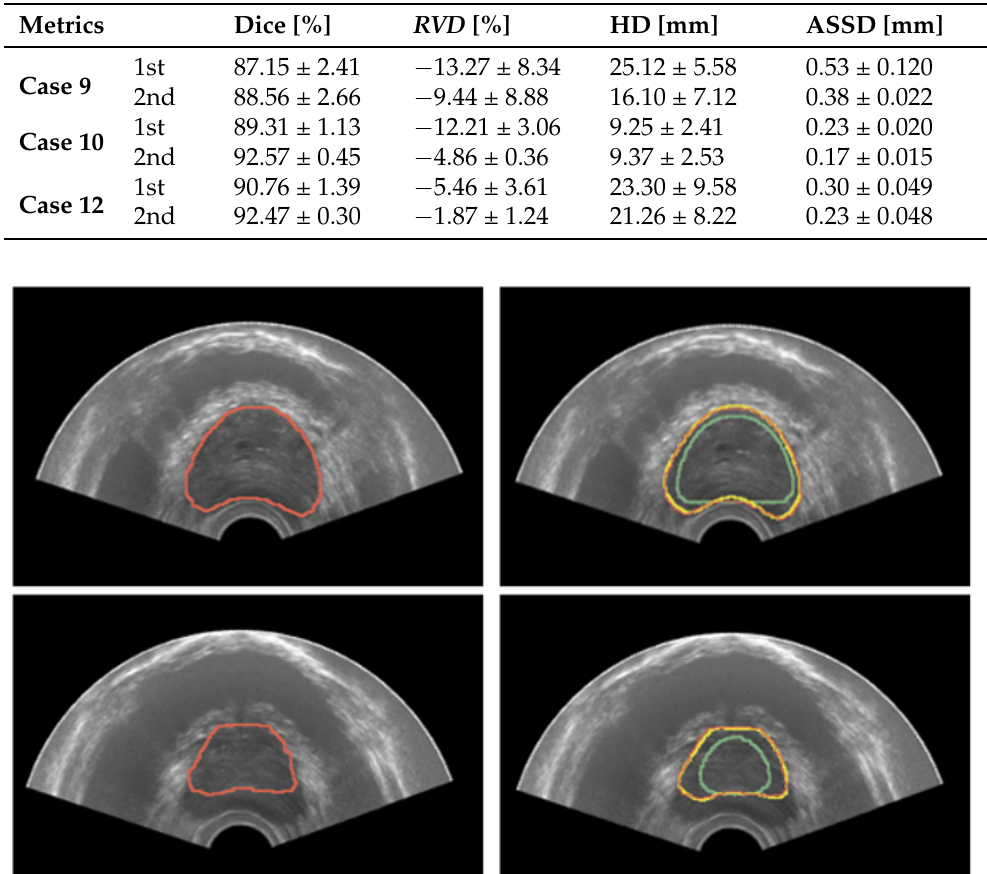
Table 3. Quantitative metrics results for TRUS prostate segmentation with the proposed superellipse- based approach. Results are reported for both the first and second iterations of the algorithm run.